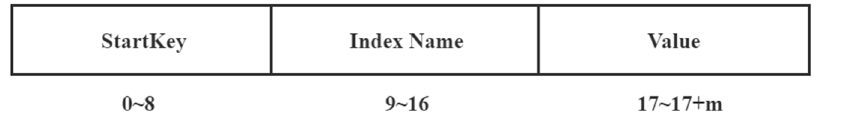
Figure 12. The RowKey of designed secondary index.